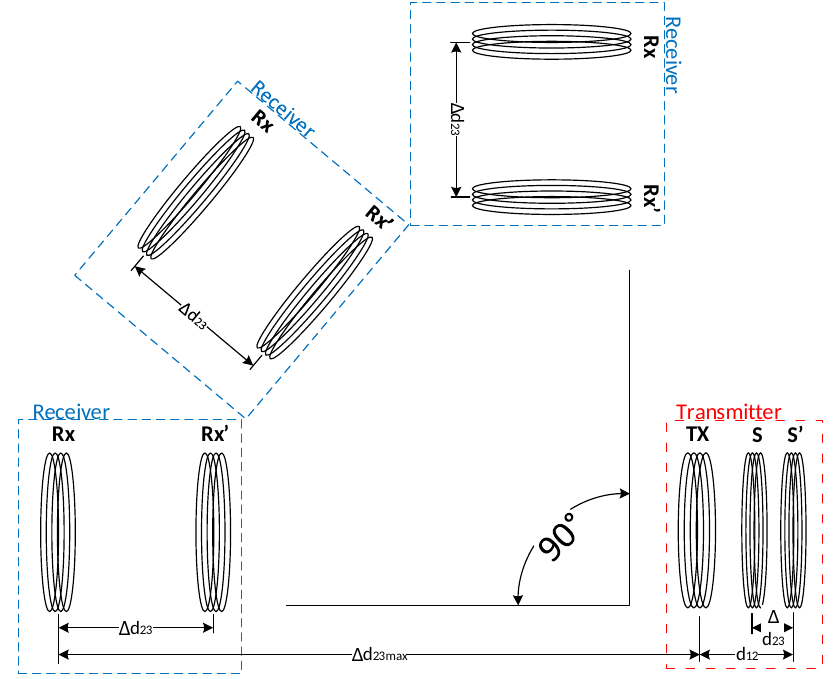
Figure 13. Positioning of receiver for the measurement of angle